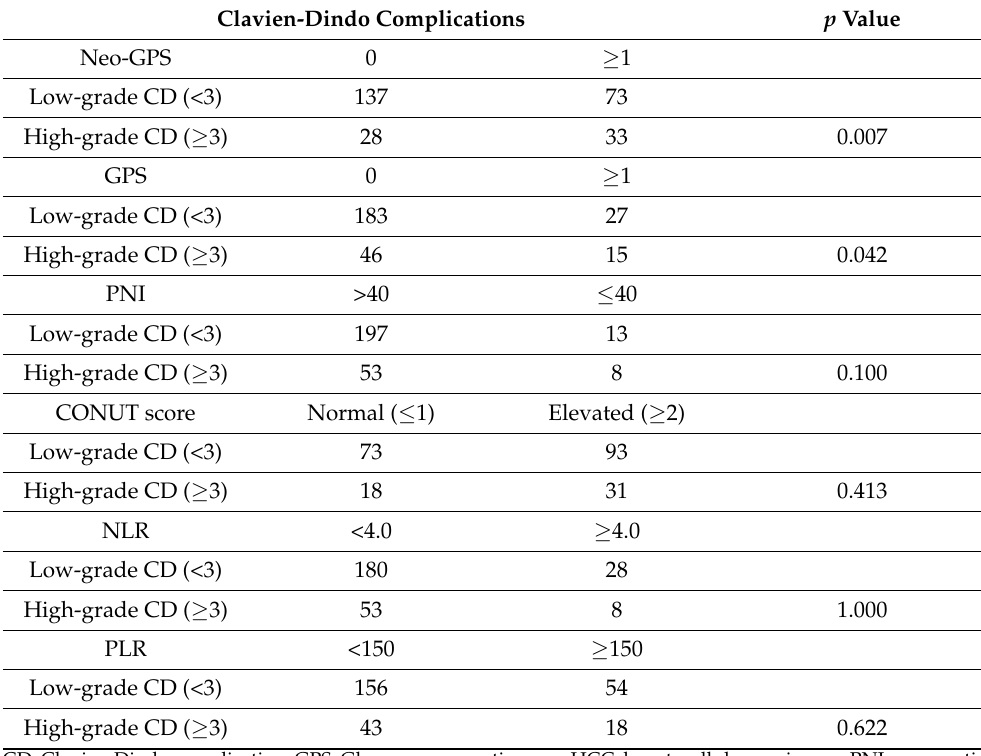
Table 3. Rates of high-grade Clavien-Dindo complications according to the assessment tool. Clavien-Dindo Complications p